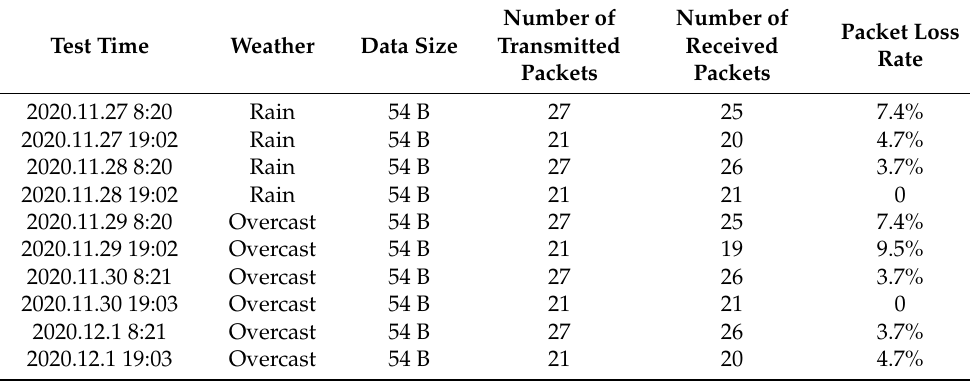
Table 4. Packet loss rate (without the packet creation mode).